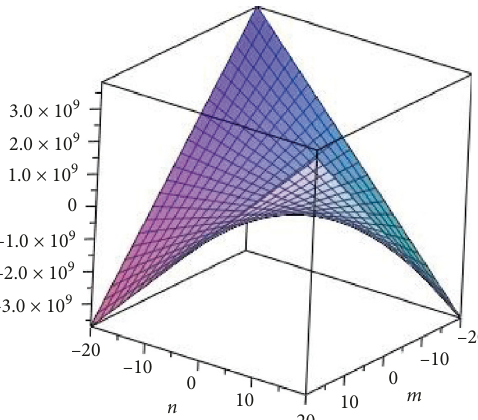
Figure 5: The 3D plot of Randi´c index for BR ( m,n ) .